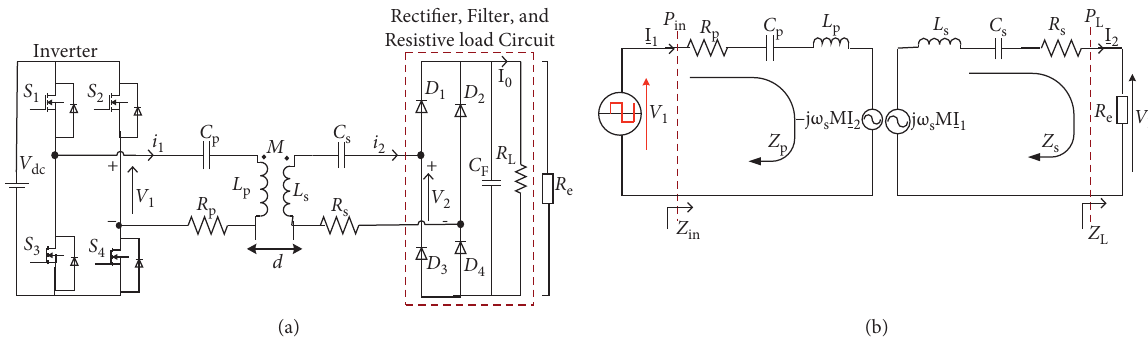
Figure 4: Electrical circuit of an ICPT system with series-series capacitors: (a) full circuit; (b) equivalent